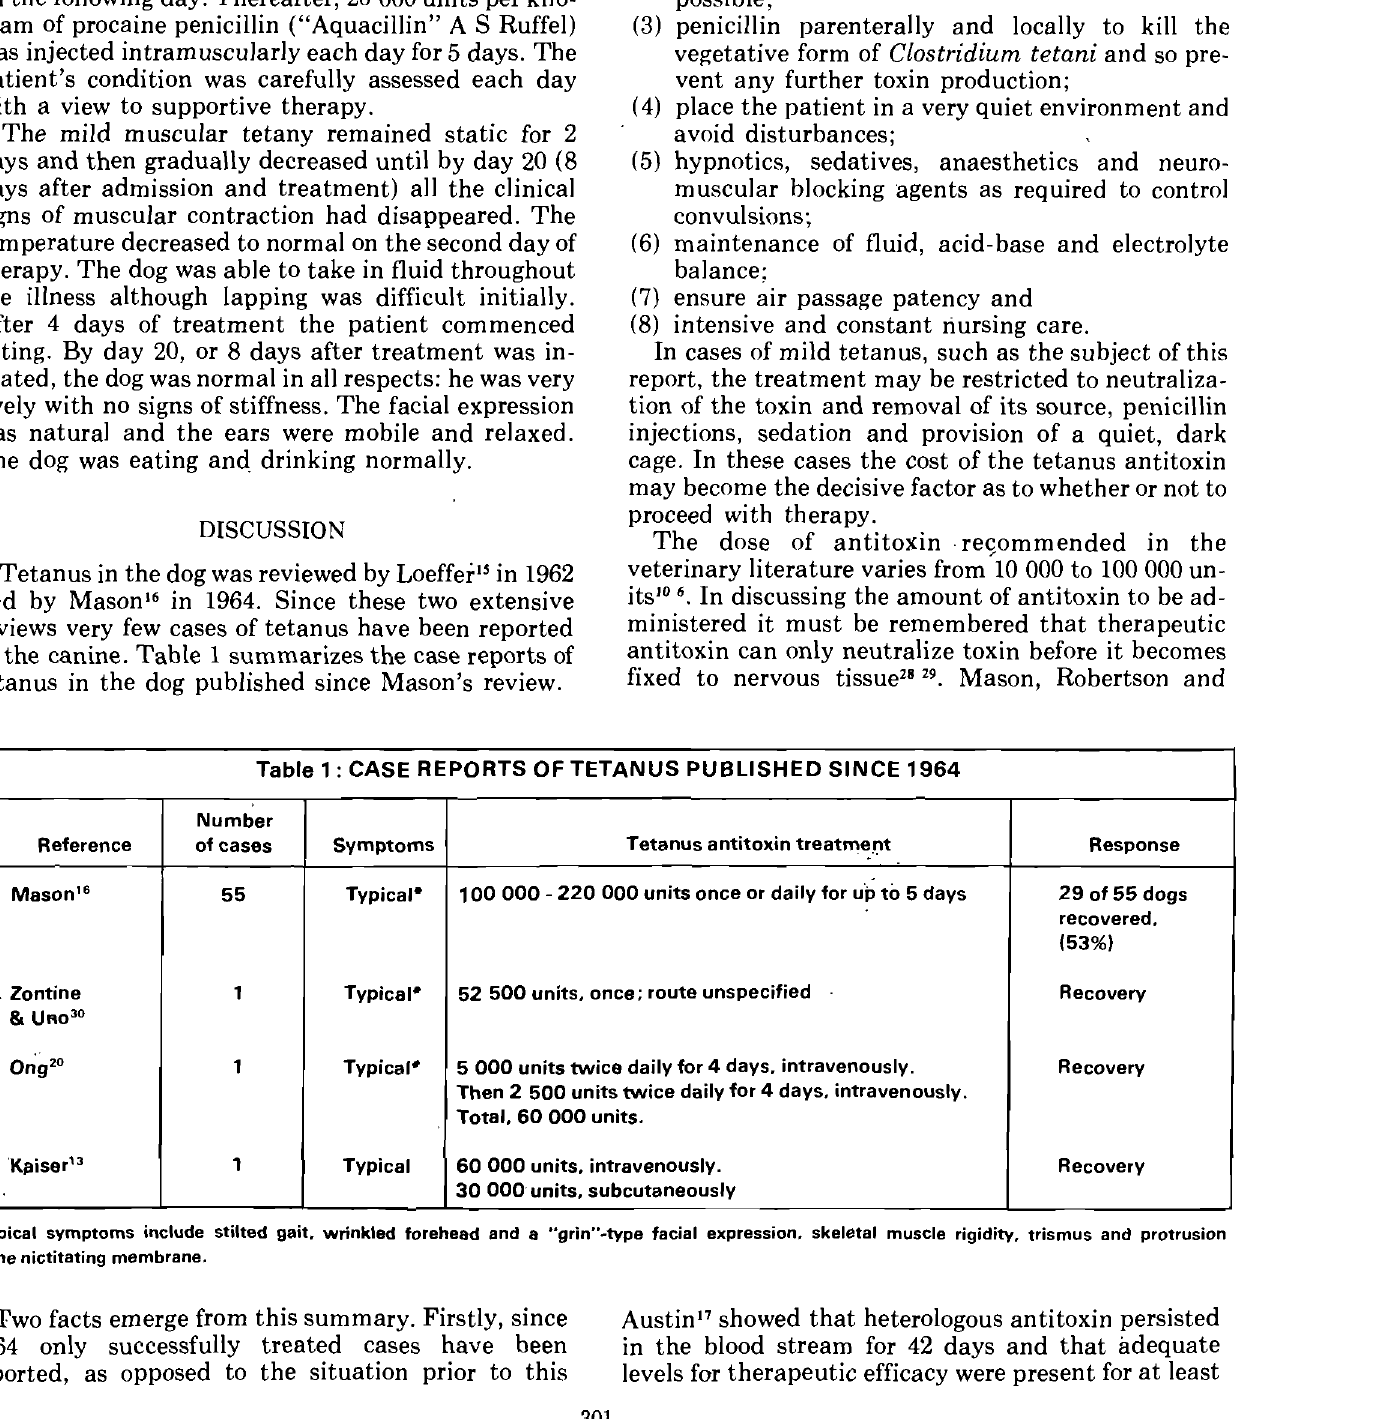
Table 1 : CASE REPORTS OF TETANUS PUBLISHED SINCE